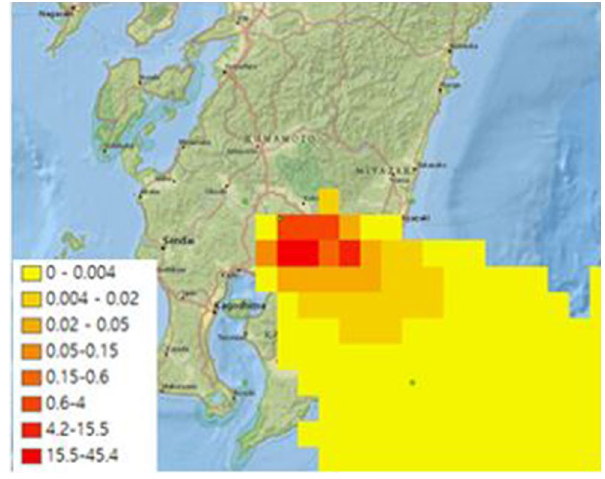
Figure 3. Ash concentration near ground and deposition by PUFF–UAF